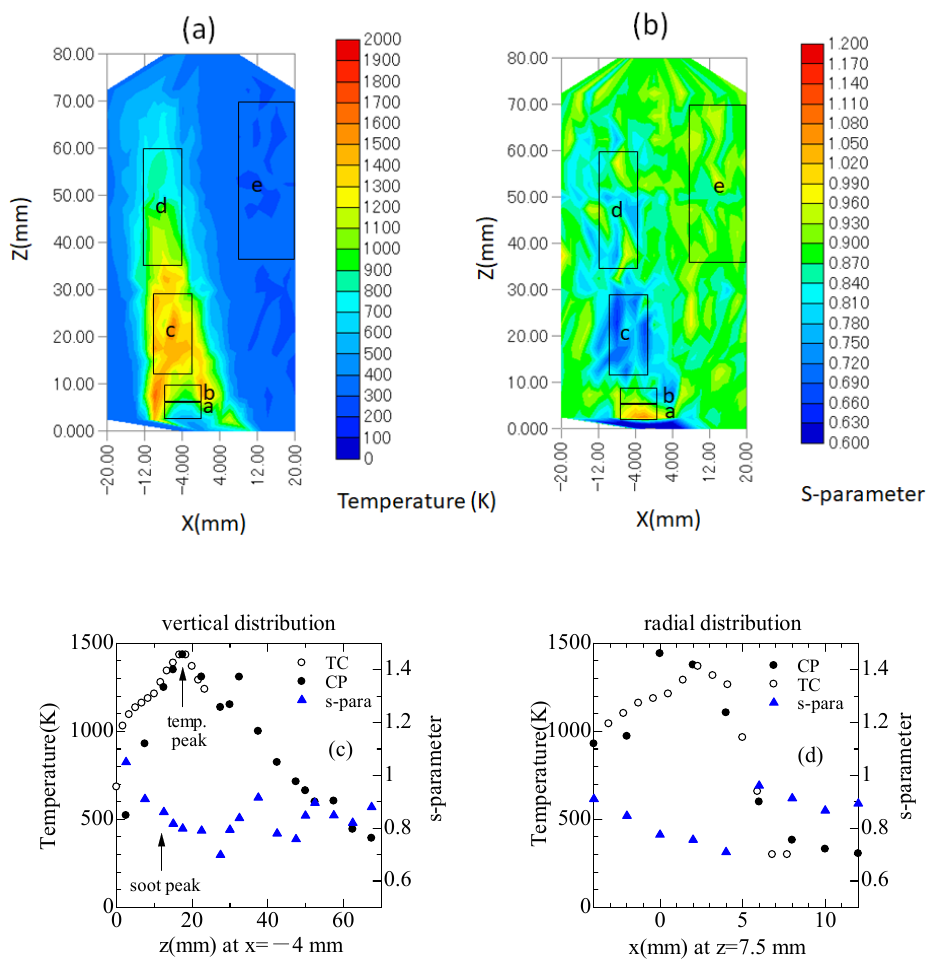
Figure 5. ( a ) Temperature distribution of the laminar diffusion flame obtained from Figure 2a,b s-parameter distribution of the laminar diffusion flame. ( c ) The temperature distributions along z -axis at x = − 4 mm in ( a , b ) measured by Compton scattering (CP) and a thermocouple (TC). The s-parameters (s-para) are also shown. ( d ) The temperatures (CP and TC) and s-parameter (s-para) distributions along to the radial direction ( x